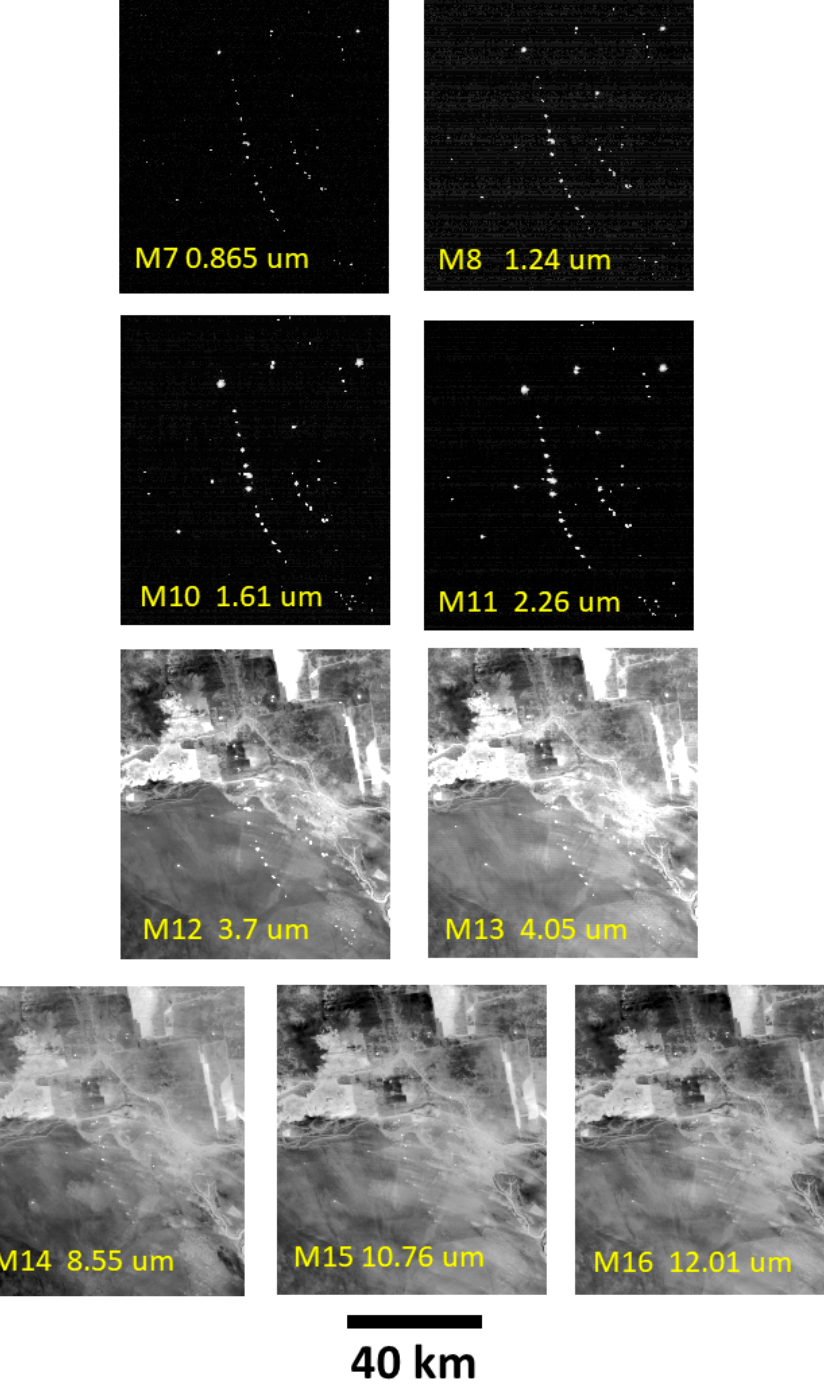
Figure 3. VIIRS night-time satellite images of gas flares near Basra, Iraq from 22 March 2018. There are two strings of flares near the center of the image, plus many others. The flares are brightest and most evident in the two SWIR bands, M10 and M11, where they are embedded in the sensor’s noise floor. The flares become gradually dimmer stepping towards both shorter and longer wavelengths. In bands M12–M16, the image features are dominated by the radiant self-emission from the Earth’s surface and